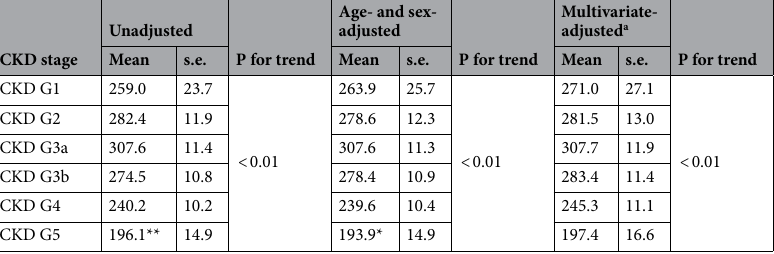
Table 2. Association between CKD stage and the quantity of vegetables consumed per day. CKD, chronic kidney disease; s.e., standard error. **P < 0.01 vs mean value of CKD G1, *P < 0.05 vs mean value of CKD G1. a Adjusted for age, sex, diabetes, history of cardiovascular disease, systolic blood pressure, body mass index, serum albumin concentration, low-density lipoprotein cholesterol, log-C-reactive protein, and urinary protein/ creatinine